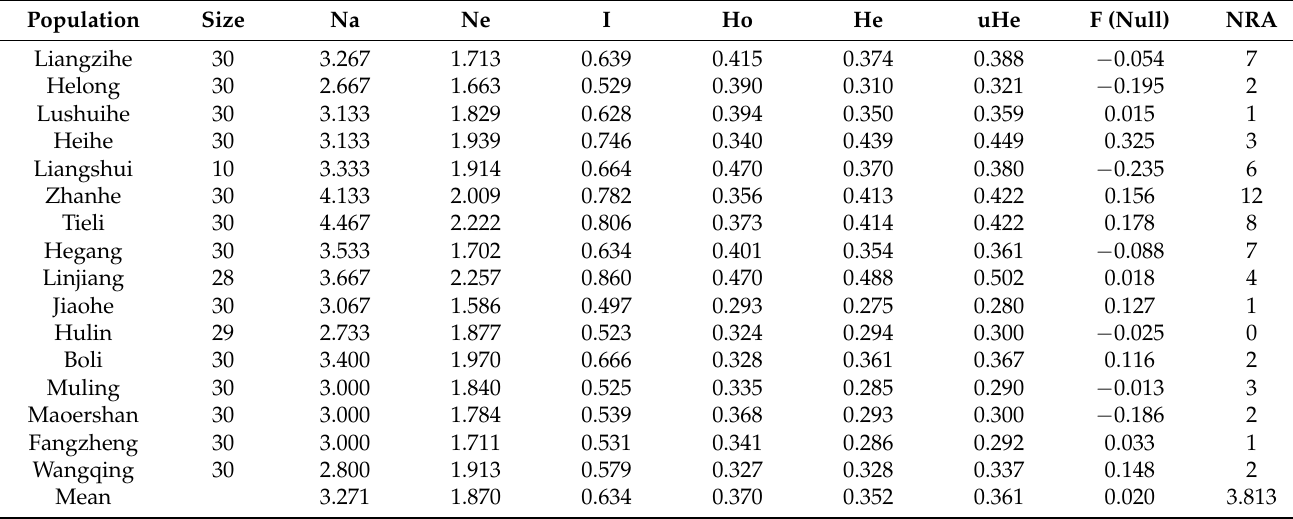
Table 2. Genetic diversity estimates for the 16 P. koraiensis populations based on 15 EST-SRRs markers.